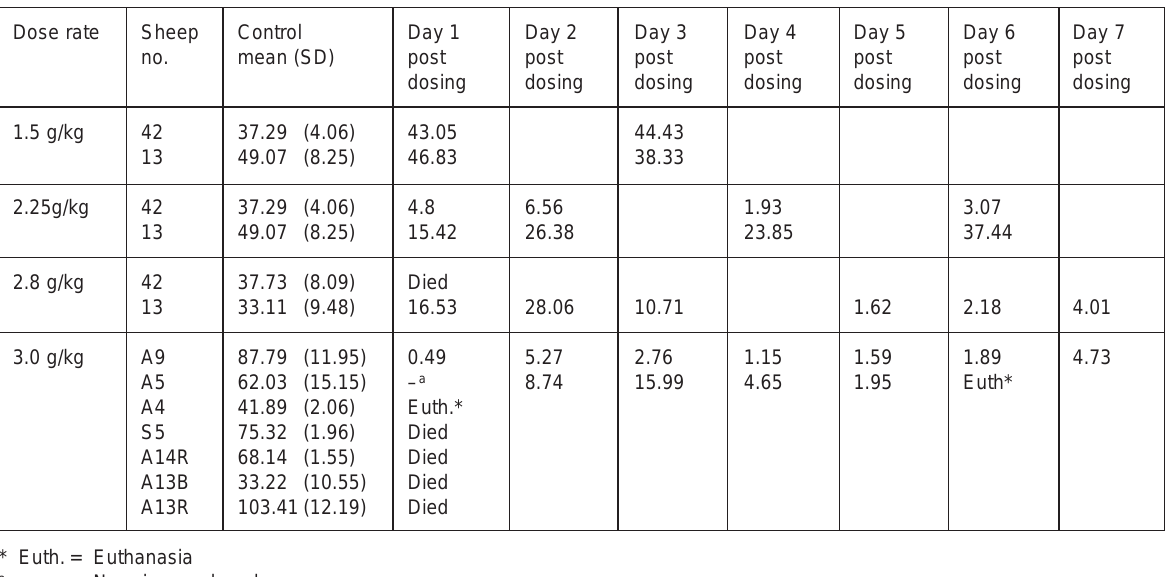
TABLE 3 Glomerular filtration rates ( l /day) of sheep—control values and values following dosing with Nolletia gariepina Dose rate Sheep